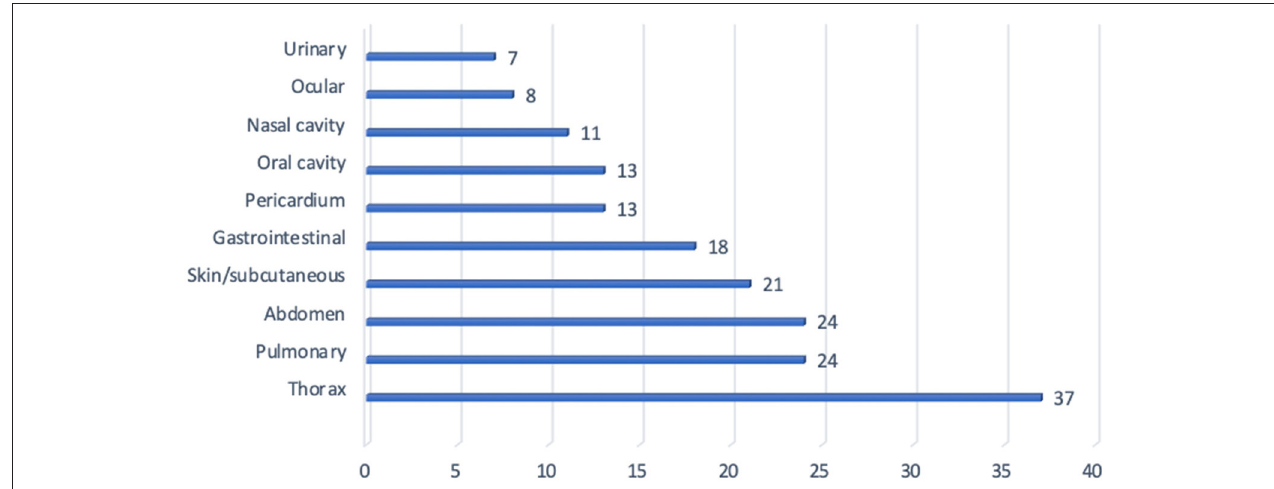
FIGURE 1 | Locations of hemorrhage.